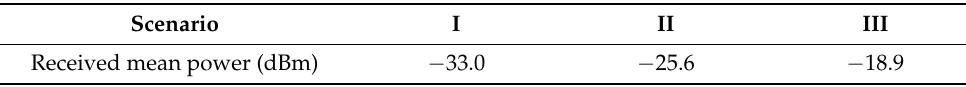
Figure 3. Third communication scenario including an UAV, which performs the role of intermediary between the boat and the base station. Table 1. Summarizes the results to the different scenarios.